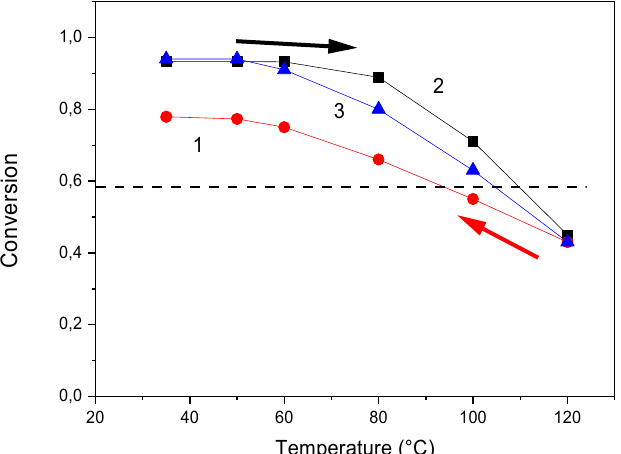
Figure 5. Conversion of the DA reaction in F4D2000–DPBMI network during cooling and heating runs. Rate of cooling/heating = 3 °C /min. Curves: 1 cooling, 2 heating, and 3 equilibrium conditions, - - - gel-point conversion, theory